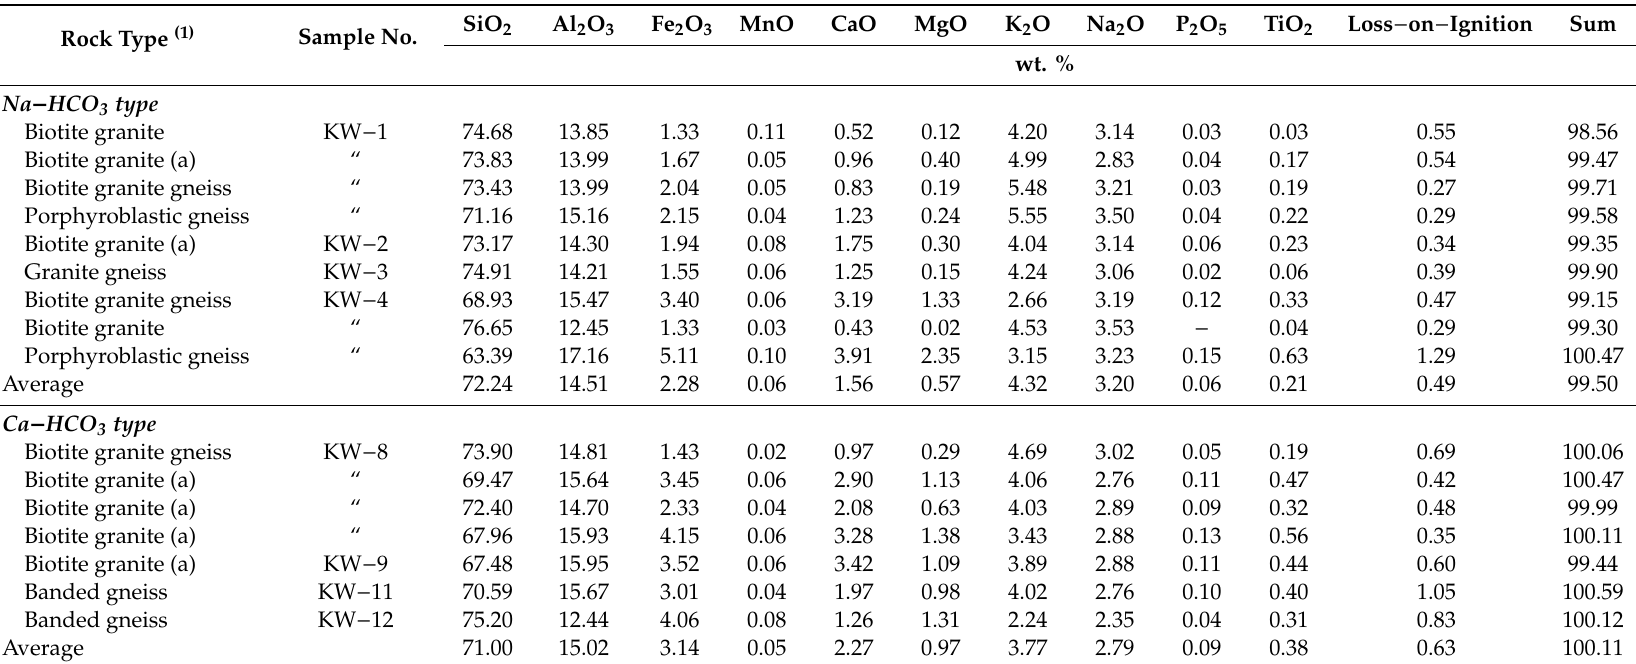
Table 4. Chemical compositions of rock samples collected from the vicinity of CO 2 − rich water in the Gangwon Province of South